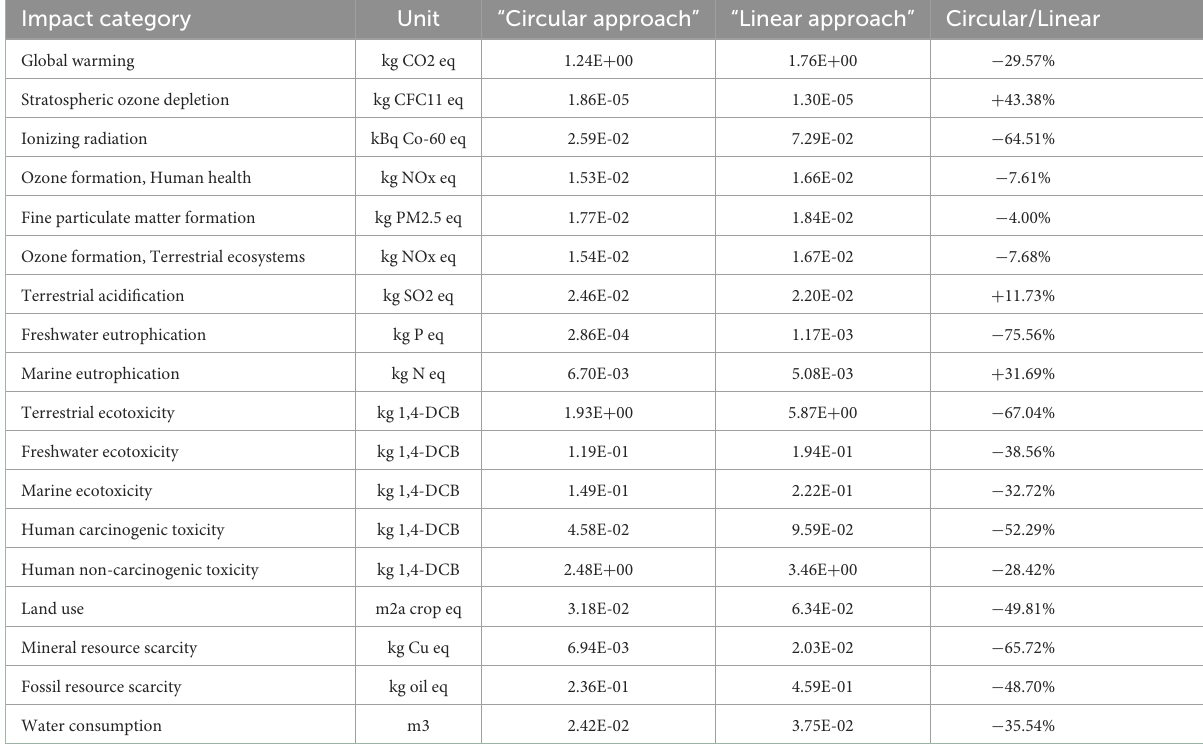
TABLE 3 Characterization of impacts related to 1kg of EVOO. Impact category Unit “Circular approach” “Linear approach”